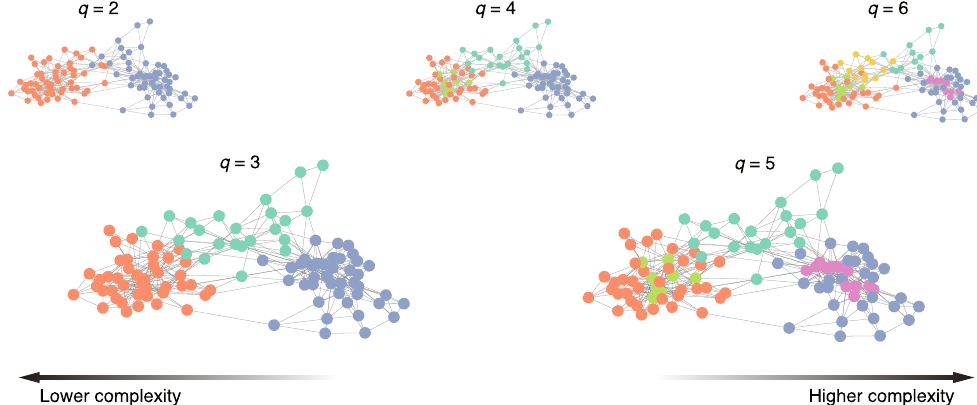
Figure 1. Partitions of the network of books about US politics. The inferred cluster assignments for various input numbers of clusters q . The vertices with the same colour belong to the same cluster. The partition with large q has a higher resolution and is obtained by fitting a model that has a higher